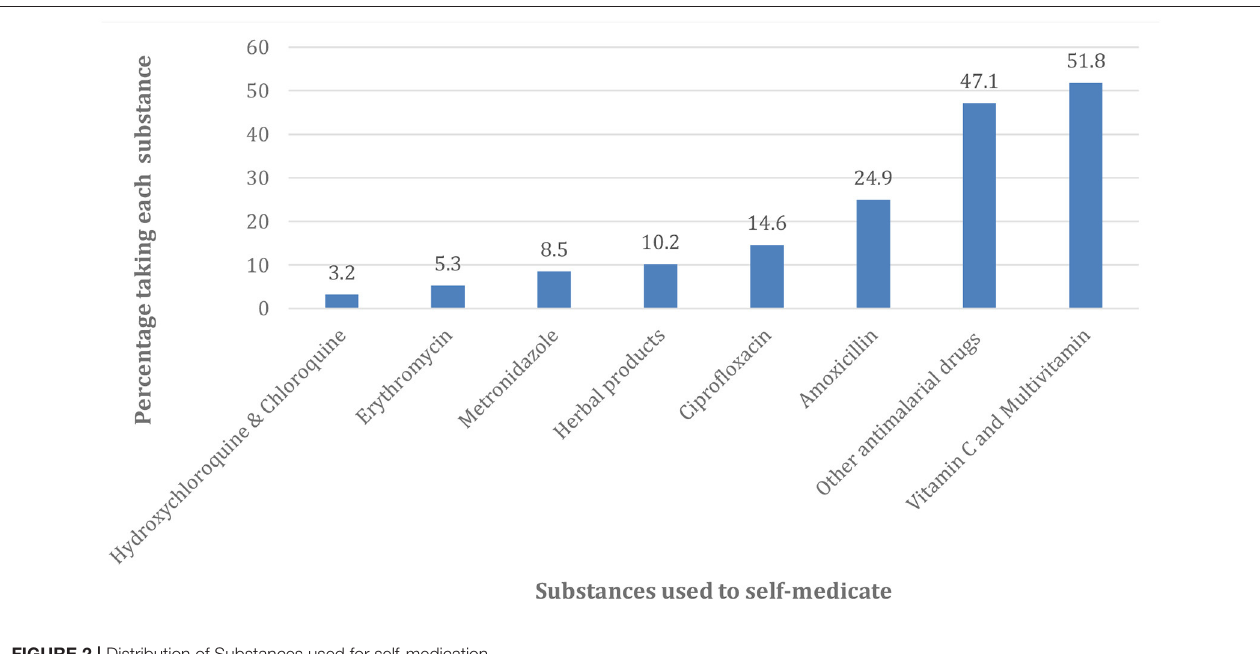
FIGURE 2 | Distribution of Substances used for self-medication.